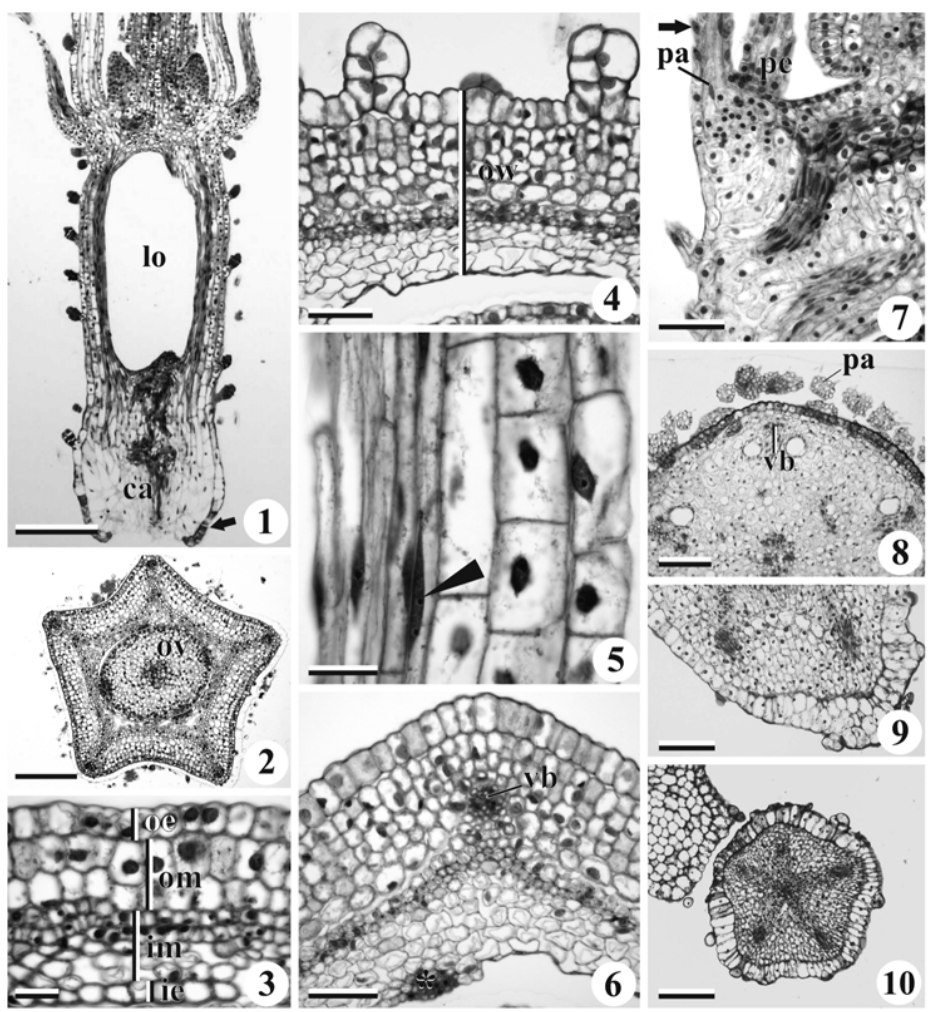
Fig. 1 – Ovary of the floral bud. Figs. 1, 5, 7, 9 – Longitudinal sections. Figs. 2-4, 6, 8, 10 – Transversal sections. Fig. 1 –